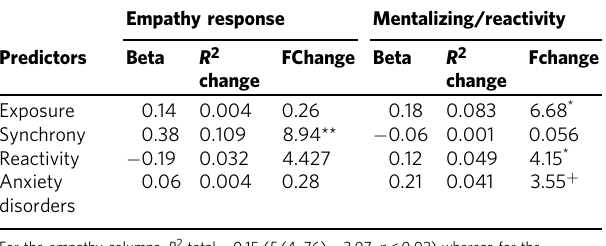
Table 1 Hierarchical linear regression predicting neural response from fi rst decade variables Empathy